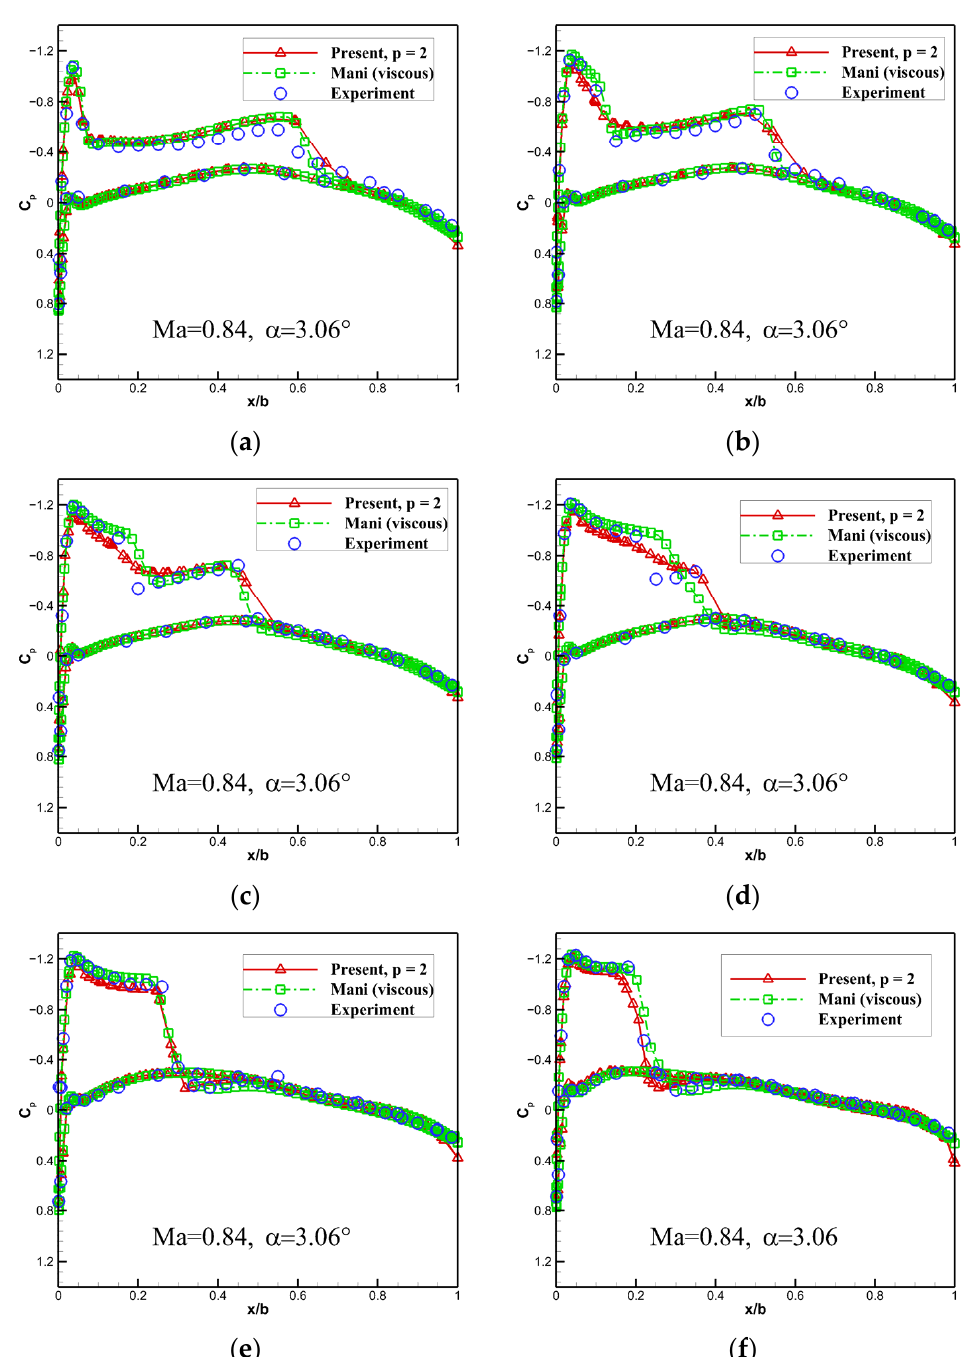
Figure 15. Contours of pressure coefficient (𝑀𝑎 = 0.84, 𝛼 = 3.06°) .